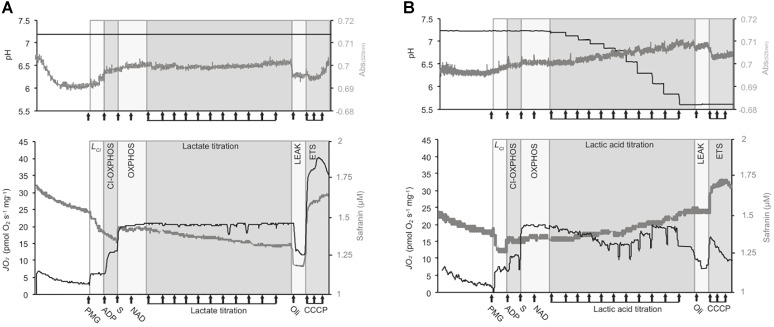
Representative traces of the respirometry protocol. Experiments were conducted with OroborosTM O2ks on isolated mt and permeabilized brain from triplefin fish. The medium pH (top panels, black traces), Volmt (top panels, gray traces), mt respiration rates (“JO2,” lower panel, black traces) and mt membrane potential (ΔΨm, lower panels, gray traces) are presented in two different graphs. However, a maximum of three parameters (JO2, medium pH and ΔΨm assessed on permeabilized brain; or JO2, medium pH and Volmt assessed on isolated mt) was assessed in a single experiment. Permeabilized brain or isolated mt from triplefin fish brain were introduced in the O2k chamber and left to recover and signals to stabilize for 20 min. The LEAK state supported by CI (LCI) was mediated by the addition of CI-linked substrates (PMG for pyruvate, malate, and glutamate) at saturating concentrations. The addition of ADP then activates CI-mediated OXPHOS and the addition of saturated succinate (S) allowed the measurement of full OXPHOS capacities with the contribution of both CI and CII. Then, NAD+ (75 μM) was added to stimulate extra-mt lactate oxidation into pyruvate. Buffered lactate (control samples) or unbuffered lactic acid was then titrated to 30 mM (A and B, respectively). To test for mt coupling, the ATPF0-F1 inhibitor oligomycin (Oli) was added to determine the LEAK state (affected or not by pH) followed by the uncoupler CCCP, titrated to define the maximum ETS capacity. The ΔΨm was calculated from the fluorescence signal recorded from a calibrated-safranin concentration (up to 2 μM). An increase in safranin concentration corresponds to a decrease in ΔΨm. Volmt was estimated with the absorbance at 525 nm. All experiments were performed at 20°C with sufficient O2 (between 100 and 260 μM dissolved O2).